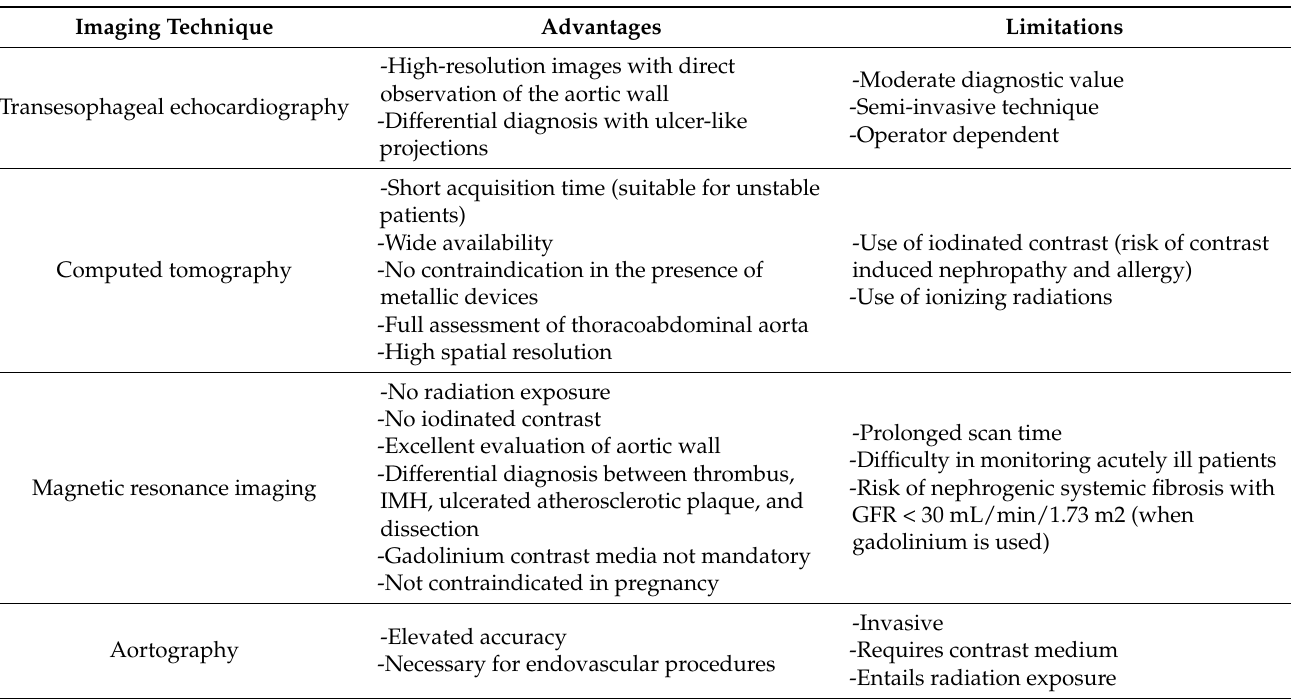
Table 3. Advantages and limitations of imaging techniques in the diagnosis of penetrating aortic